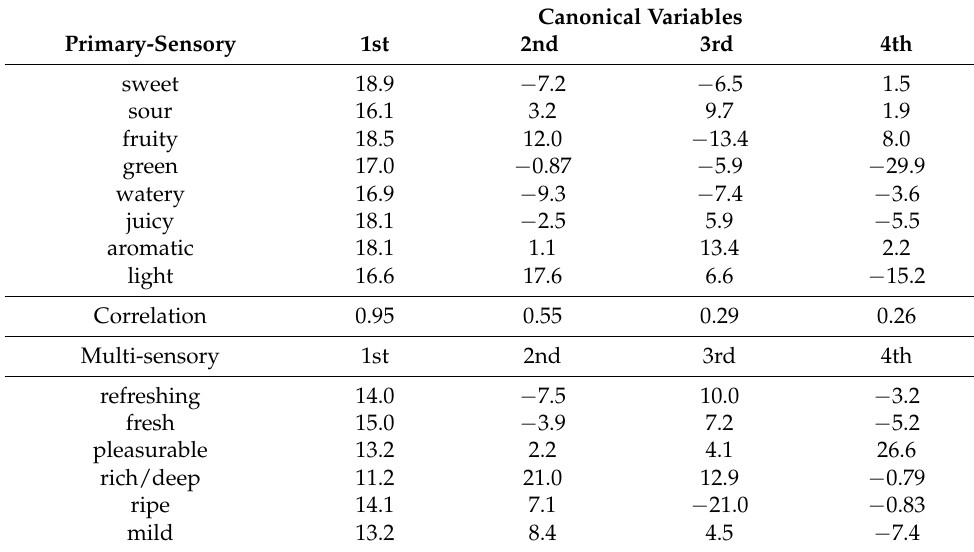
Table 5. Coefficients for 1st–4th canonical variables when the differential values of the dominance proportion curves were used for